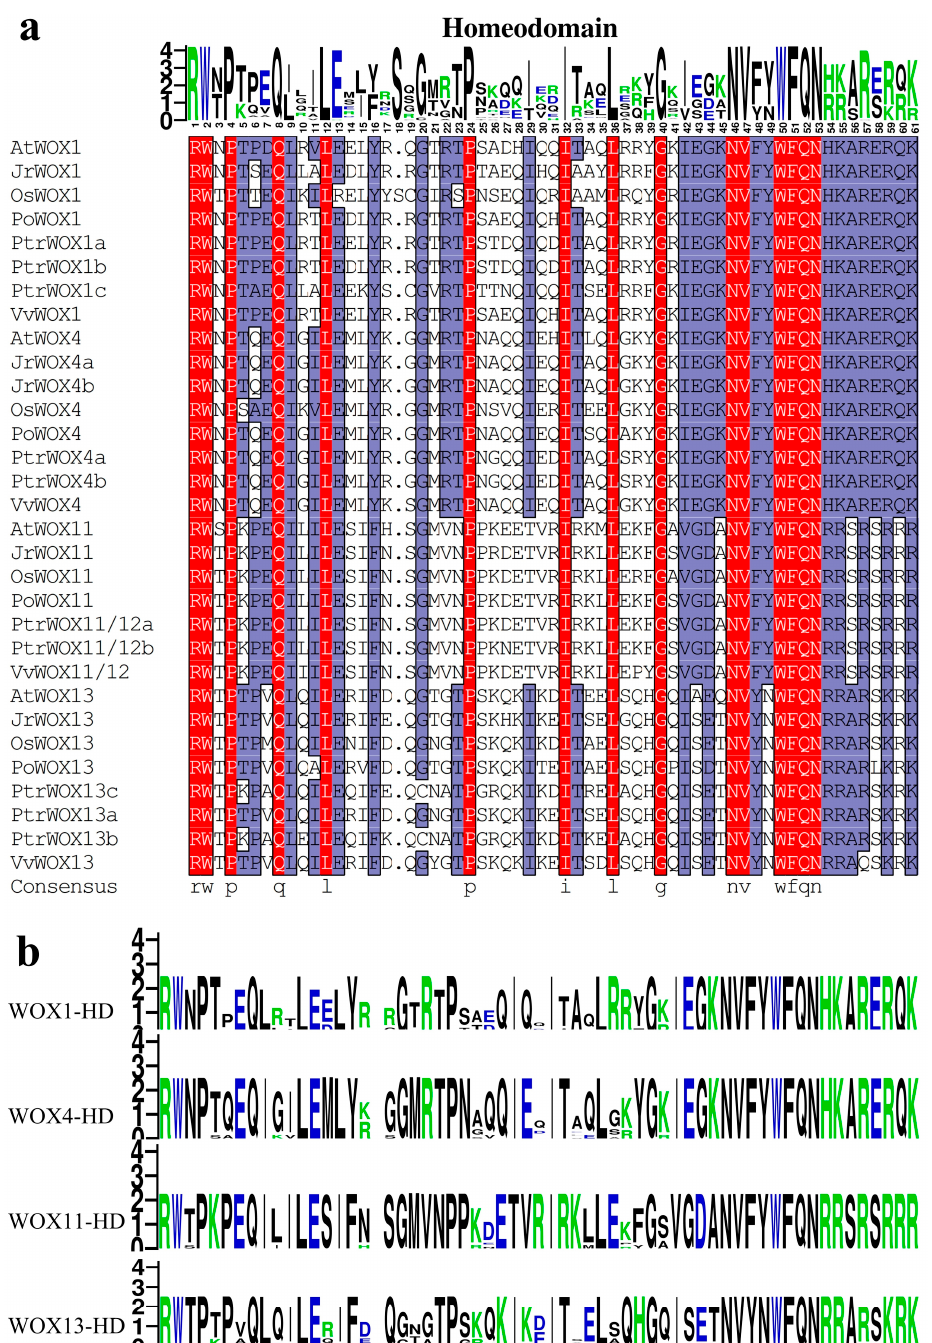
Figure 2. Multiple sequence alignment and sequence identification of WOX1, WOX4, WOX11, and WOX13 proteins. ( a ) Multiple sequence alignment of WOX1, WOX4, WOX11, and WOX13 pro- teins in six species ( A. thaliana , O. sativa , J. regia , V. vinifera , P. trichocarpa and P. suffruticosa) . The amino acid sequence similarity indicated in red was 100%, and the amino acid sequence similarity in purple was greater than or equal to 50%. ( b ) Sequence identification map of